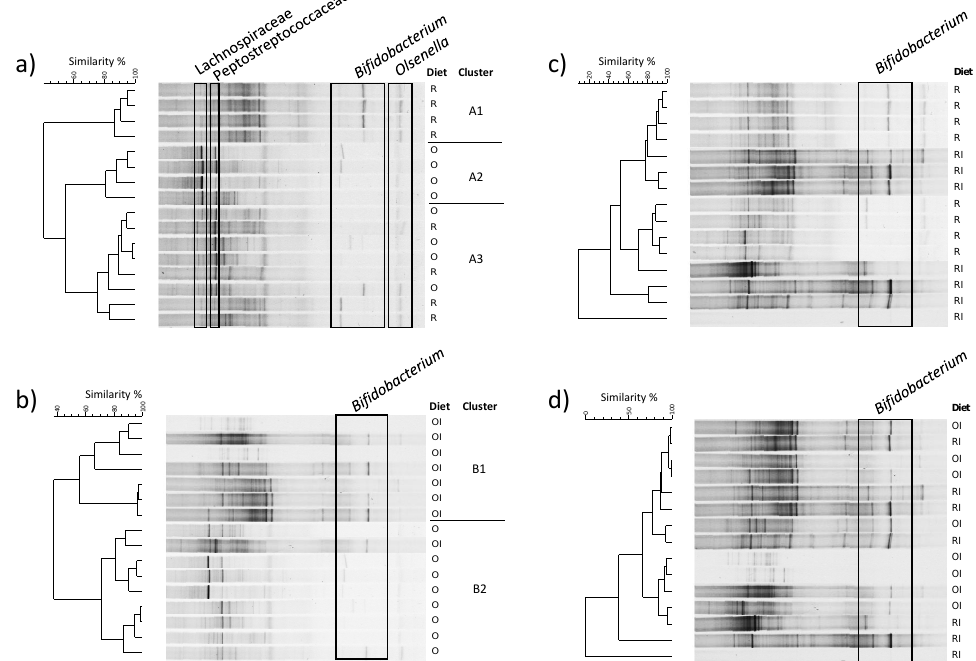
Figure 2. DGGE banding patterns of caecal bacteria obtained with universal primers. Frames depict gel positions assigned to a specific bacterial taxon based on band sequencing (see Supplementary Information, Figure S1). O and R—diets with recommended and restricted calcium intake, respectively. OI and RI—diets O and R supplemented with inulin. Paired comparisons, O vs. R ( a ), O vs. OI ( b ), R vs. RI ( c ) and OI vs. RI ( d ), were performed based on profile similarities calculated using the Pearson’s product-moment correlation coefficient. Dendrograms were constructed using the UPGMA